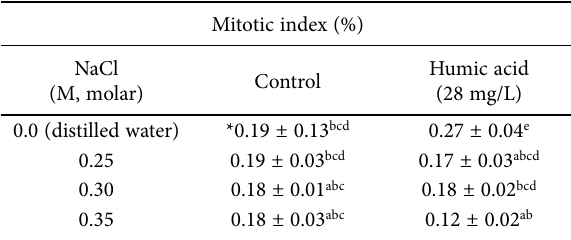
Table 1. Mitotic index of barley seeds germinated in distilled water and different NaCl concentrations after humic acid pretreatment.